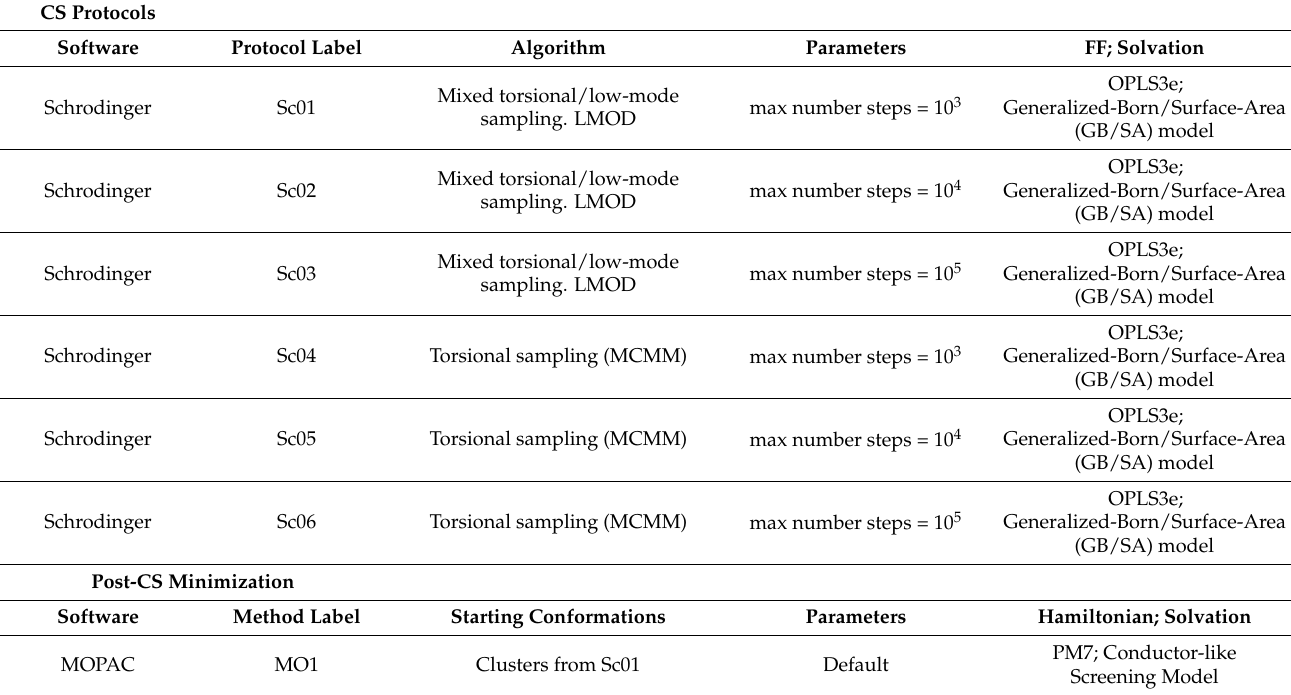
Table 1. Detailed description of the protocols used for conformational